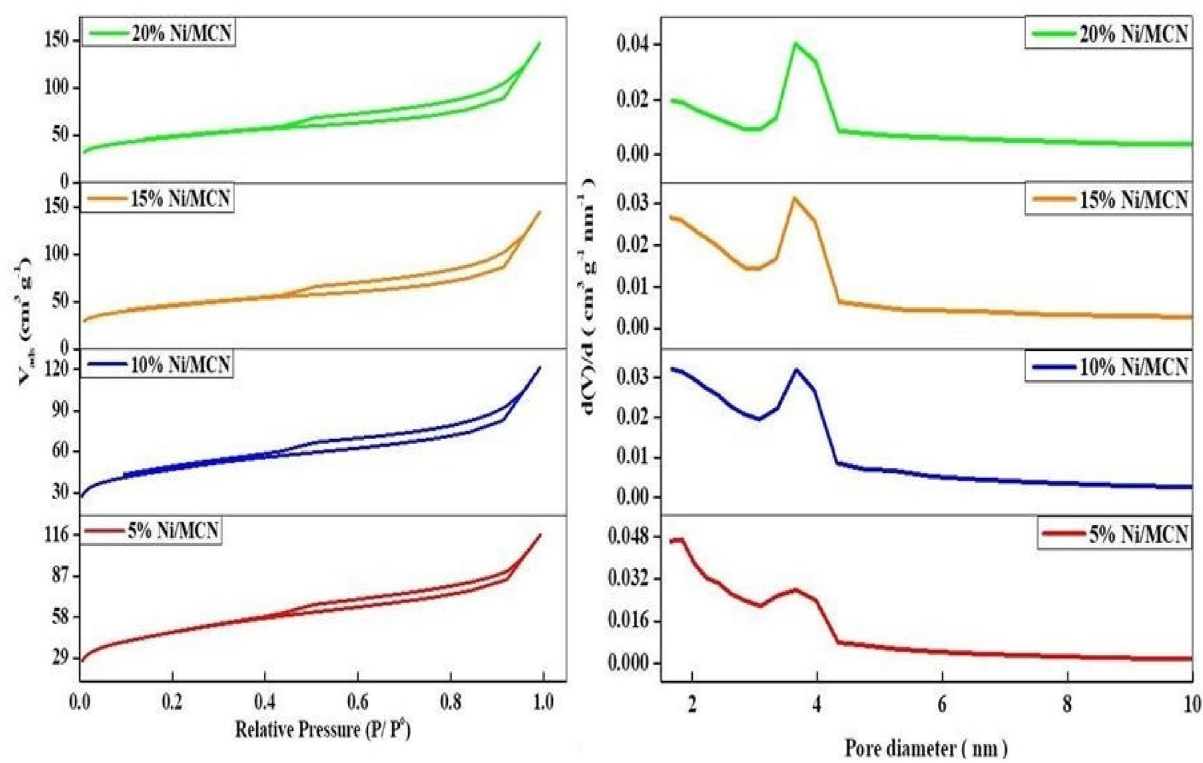
Figure 2. Nitrogen adsorption–desorption isotherm and pore size distribution of the prepared samples.